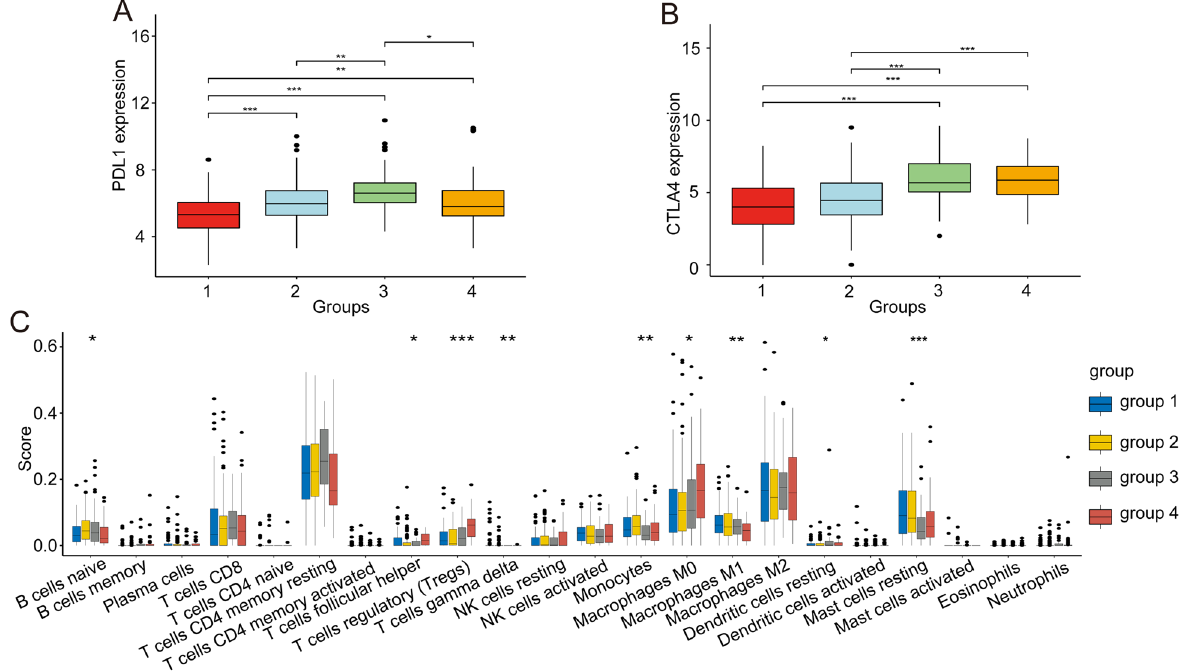
Figure 3. Differences in immune checkpoint gene expression and immune cell infiltration between subtypes. ( A ) Expression of PDL1 differed among the four subtypes, and PDL1 was significantly upregulated in group 3. ( B ) CTLA4 expression differed among subtypes. ( C ) Differences in immune cell infiltration among subtypes was based on ssGSEA, and a certain degree of immunosuppression was found in group